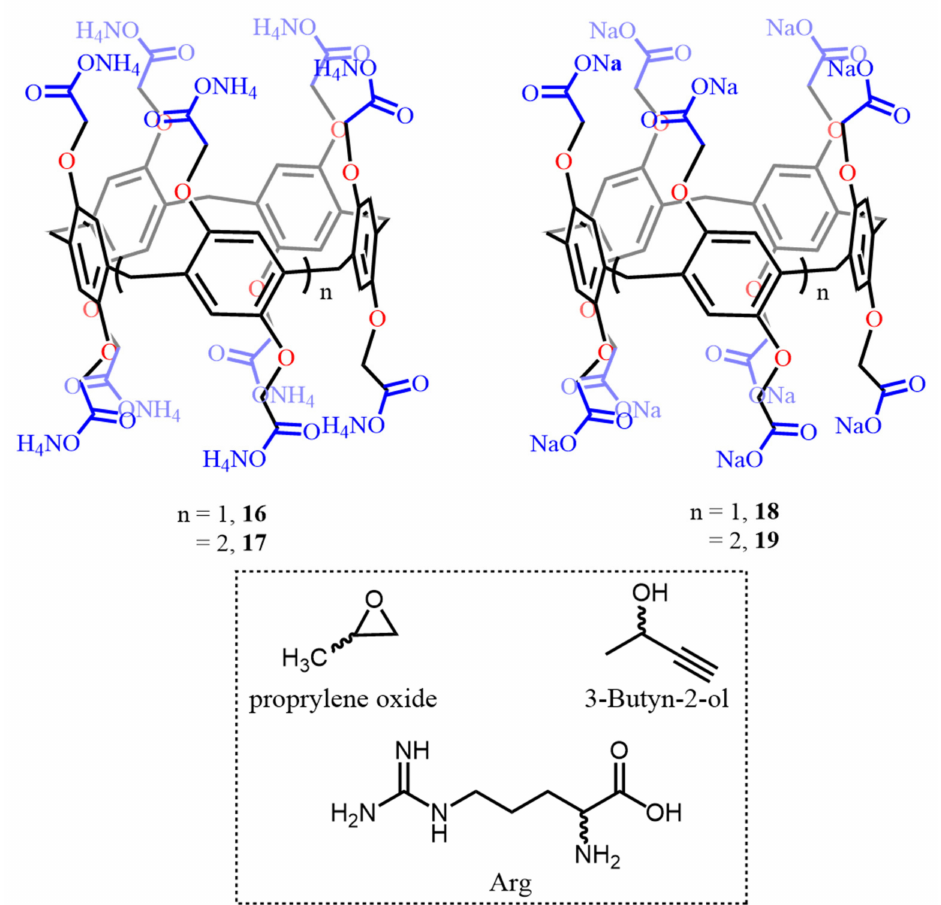
Figure 6. Chemical structures of water-soluble P[n]s with different cationic and their chiral guests. Similarly, Wang group [29] synthesized a water-soluble pillar[n]arene 18 and studied its chiroptical induction with 19 different L -amino acid ethyl ester hydrochlorides.